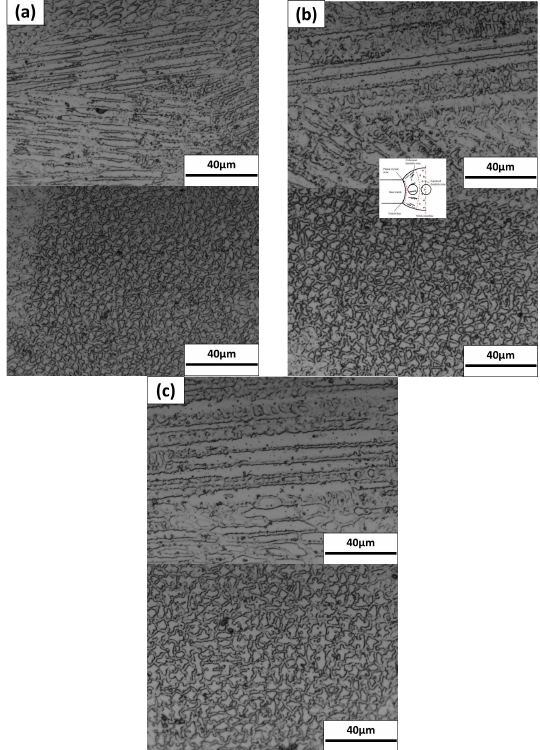
Figure 12. Variations of grain size with pulse frequency: ( a ) f = 50 Hz; ( b ) f = 70 Hz; ( c ) f = 90 Hz.